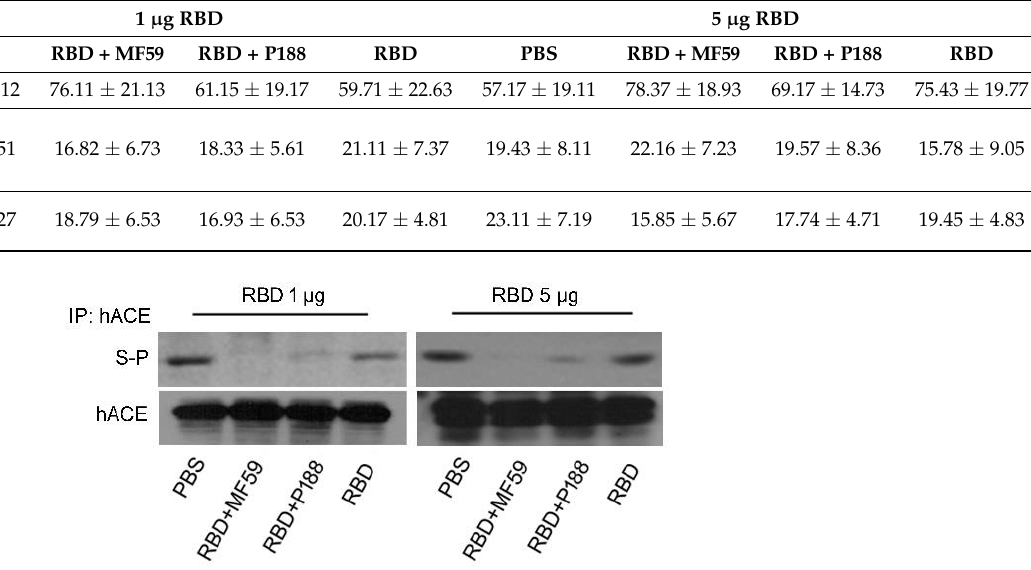
Figure 3. Sera of SARS-CoV-2 RBD vaccinated mice reduced S-protein binding activity on hACE overexpressing hepatic cells. Immunoprecipitation showed that sera of SARS-CoV-2 RBD vaccinated mice significantly repressed S-protein binding to hACE in vitro. Bar graphic presented that S-protein binding activity was highly repressed in group of RBD and P188-vaccination (RBD + P188) compared with group of RBD and MF59-vaccination (RBD +